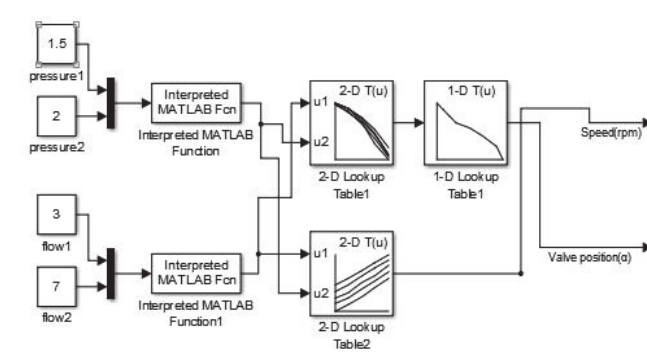
Fig. 4. The input terminal of the model.